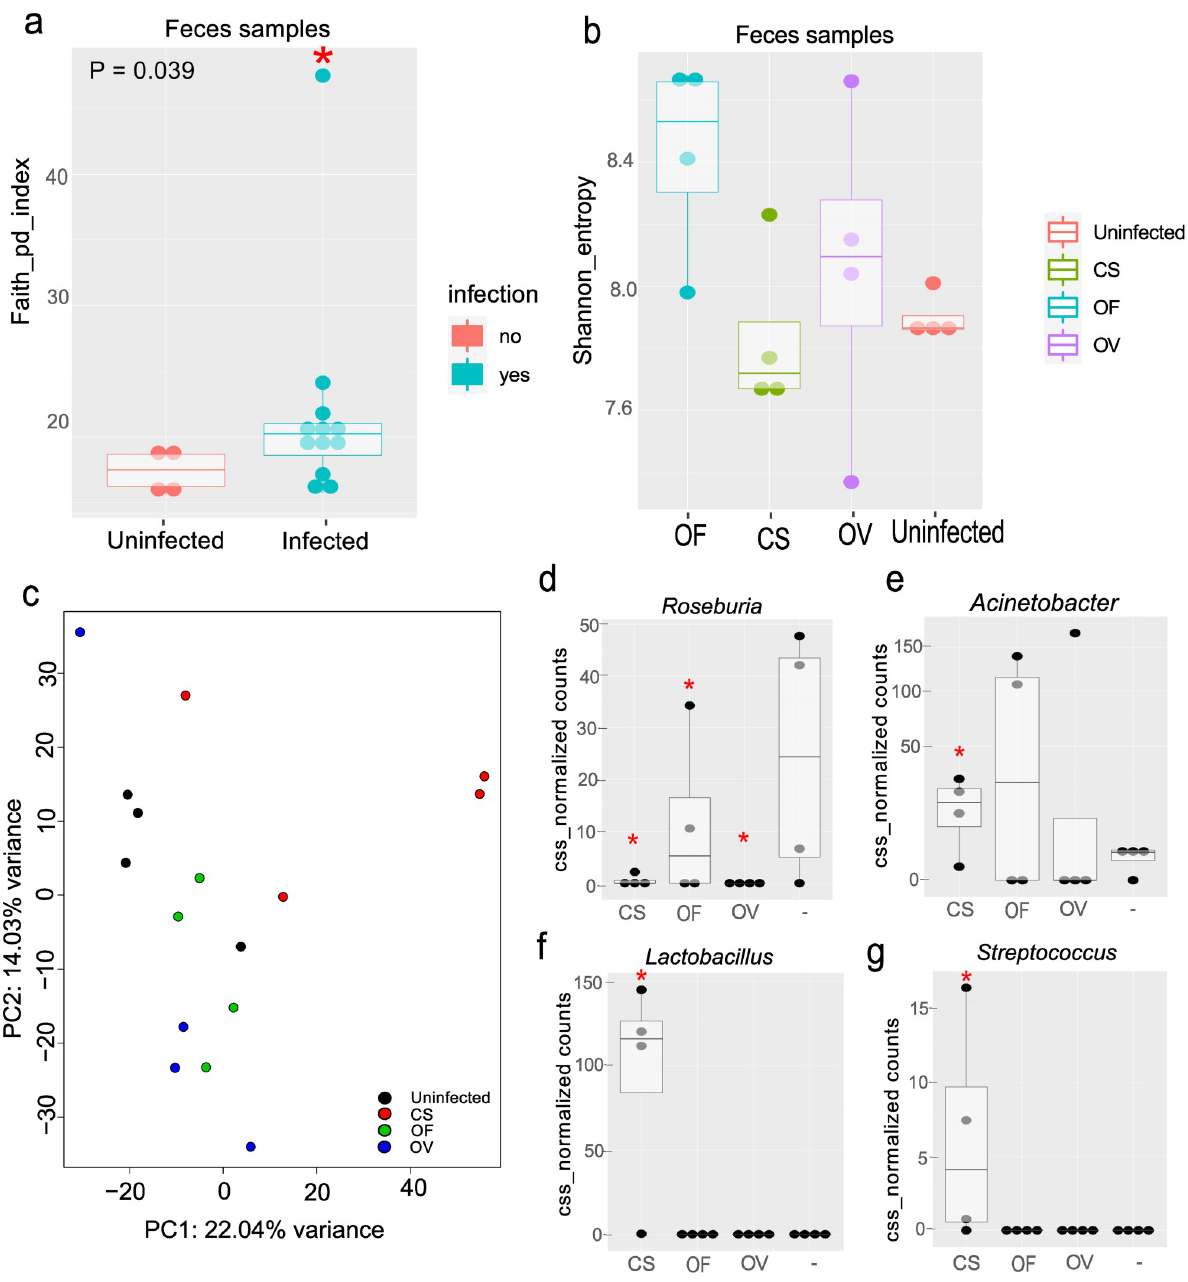
Fig 6. The results of the alpha and beta diversity analysis of the fecal samples. a. Differences in Faith’s PD between uninfected and infected samples of feces. b. Shannon’s index. c. PCoA based on Bray–Curtis distance metrics at the feature level of fecal samples from uninfected and infected hamsters (P = 0.014). d–g. Differently distributed genera among fecal samples. � False Discovery Rate < 0.05, significant changes as compared to the uninfected samples (Wilcoxon’s test of CSS-normalized counts with the Benjamini–Hochberg correction). OF: O . felineus , CS: C . sinensis , OV: O . viverrini